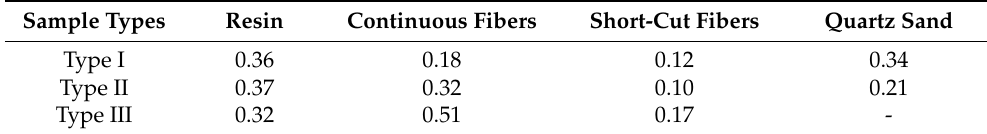
Table 1. Component content data for GFRP pipes.